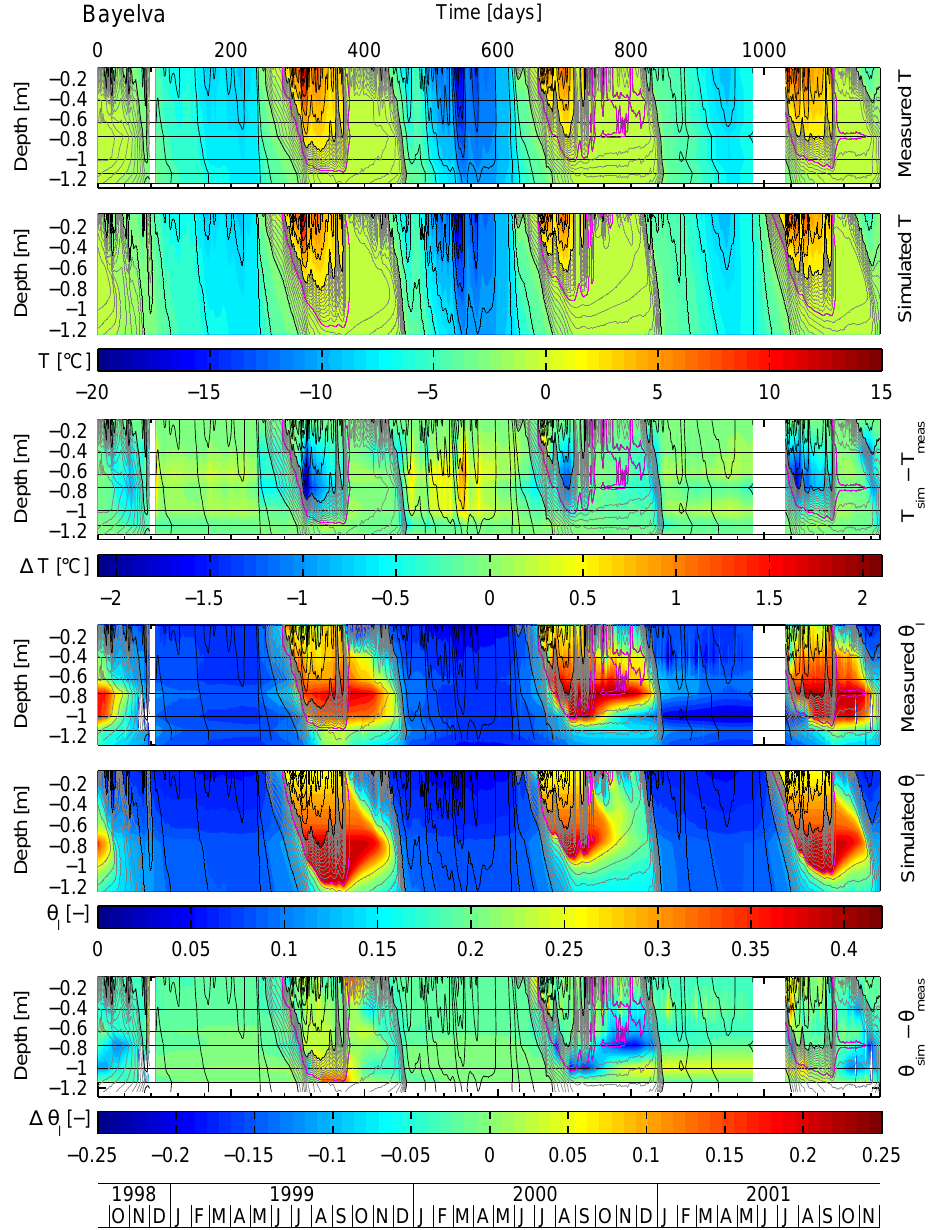
Fig. 5. Measured data and simulation results for the Bayelva simulation with conductive and convective transport by liquid water and water vapor (scenario (i)). Top two : Measured and simulated soil temperatures, with solid lines every 2 ◦ C , gray lines every 0 . 2 ◦ C between − 2 ◦ C and 2 ◦ C and a magenta line for 0 ◦ C . 3rd from top : Simulated minus measured temperatures, with the measured temperature lines repeated for cross referencing. 4th and 5th from top : Measured and simulated liquid soil water contents, with the lines from the temperature plots repeated. Bottom : Simulated minus measured water contents, with the measured temperature lines repeated. Horizontal lines represent the sensor positions.